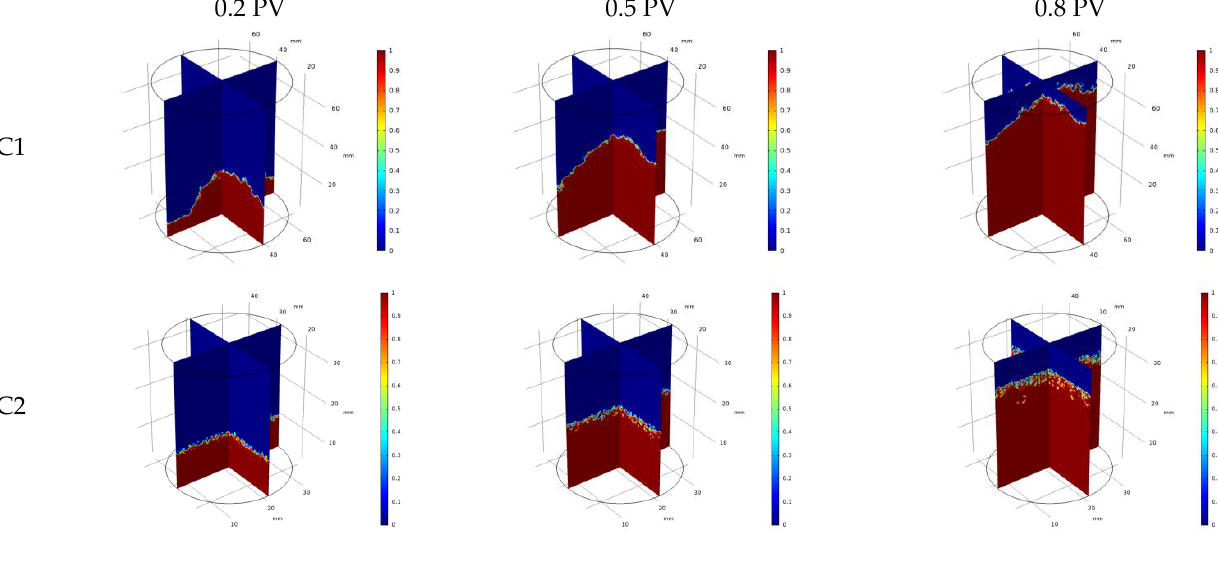
Figure 16. Outlet gas velocity with an inlet gas pressure ( p w = p g ), ( a ) Sample C1, ( b ) Sample C2.